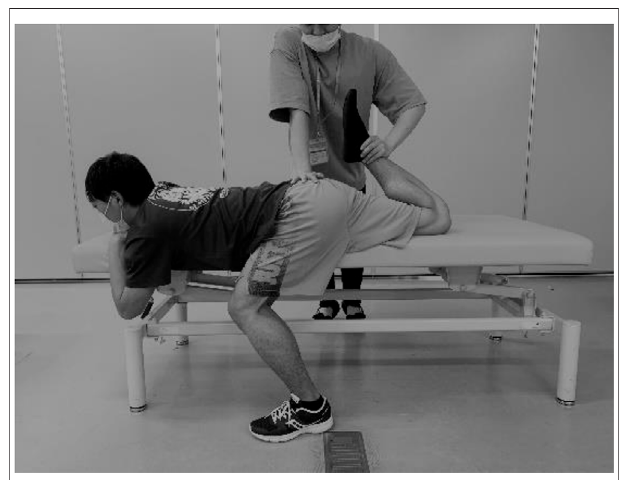
FIGURE 2 | | Knee fl exion range of motion (ROM)